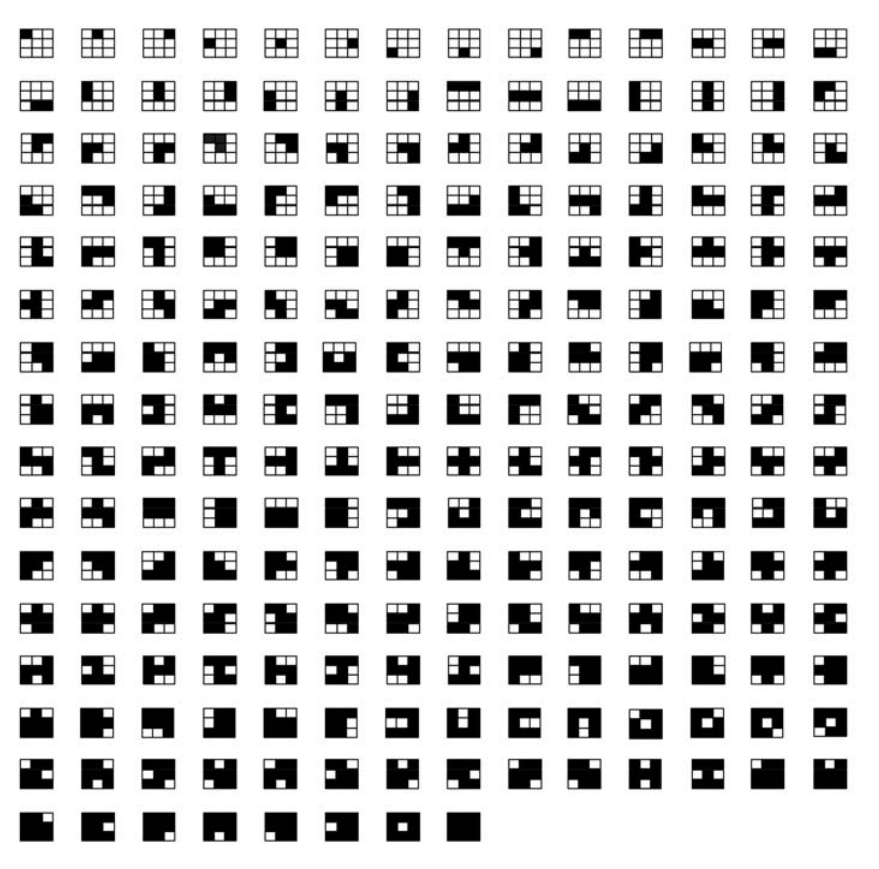
Figure 9: The 218 different symbols that can arise from the direction relation matrix with Boolean assignments with respect to two simply connected regions